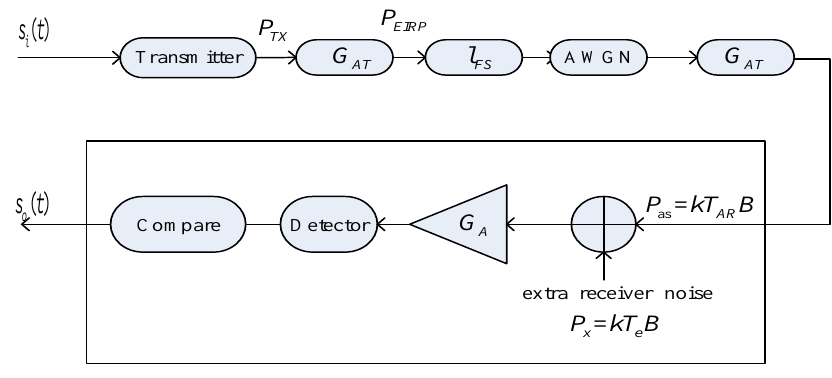
Figure 3. Sketch map of HAPS link budget.